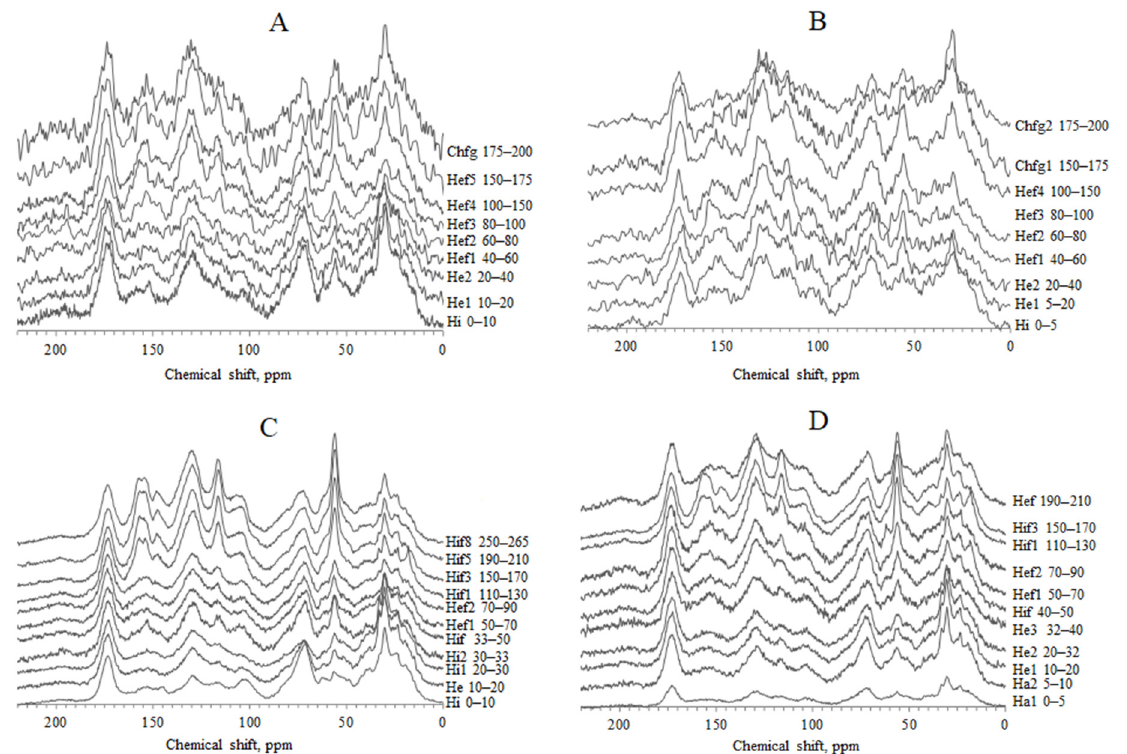
Figure 2. CP/MAS 13 C NMR spectra of HAs isolated from the Plot 1-1 ( A ), Plot 1-2 ( B ), Plot 2-1 ( C ) and Plot 2-2 ( D ).